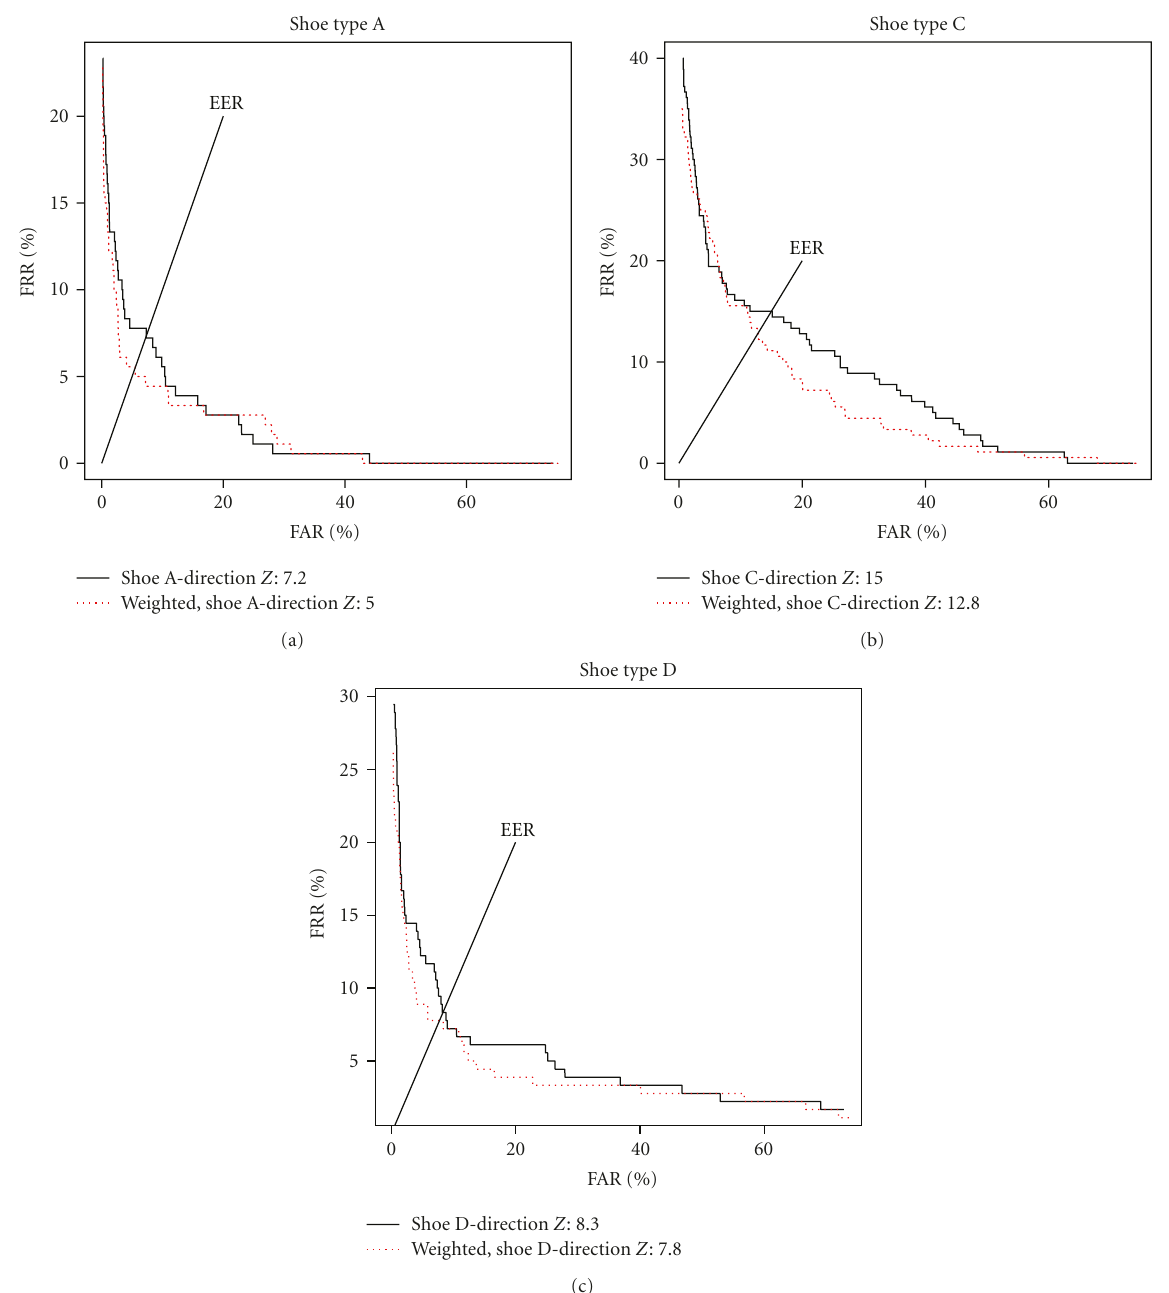
Figure 13: Ordinary (black) vrsus weighted (red) Euclidean distances.